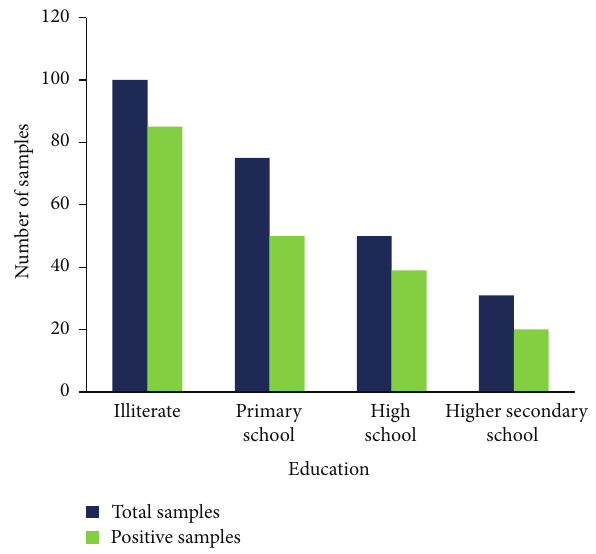
Figure 6: Education status of the low socioeconomic dwellers from south